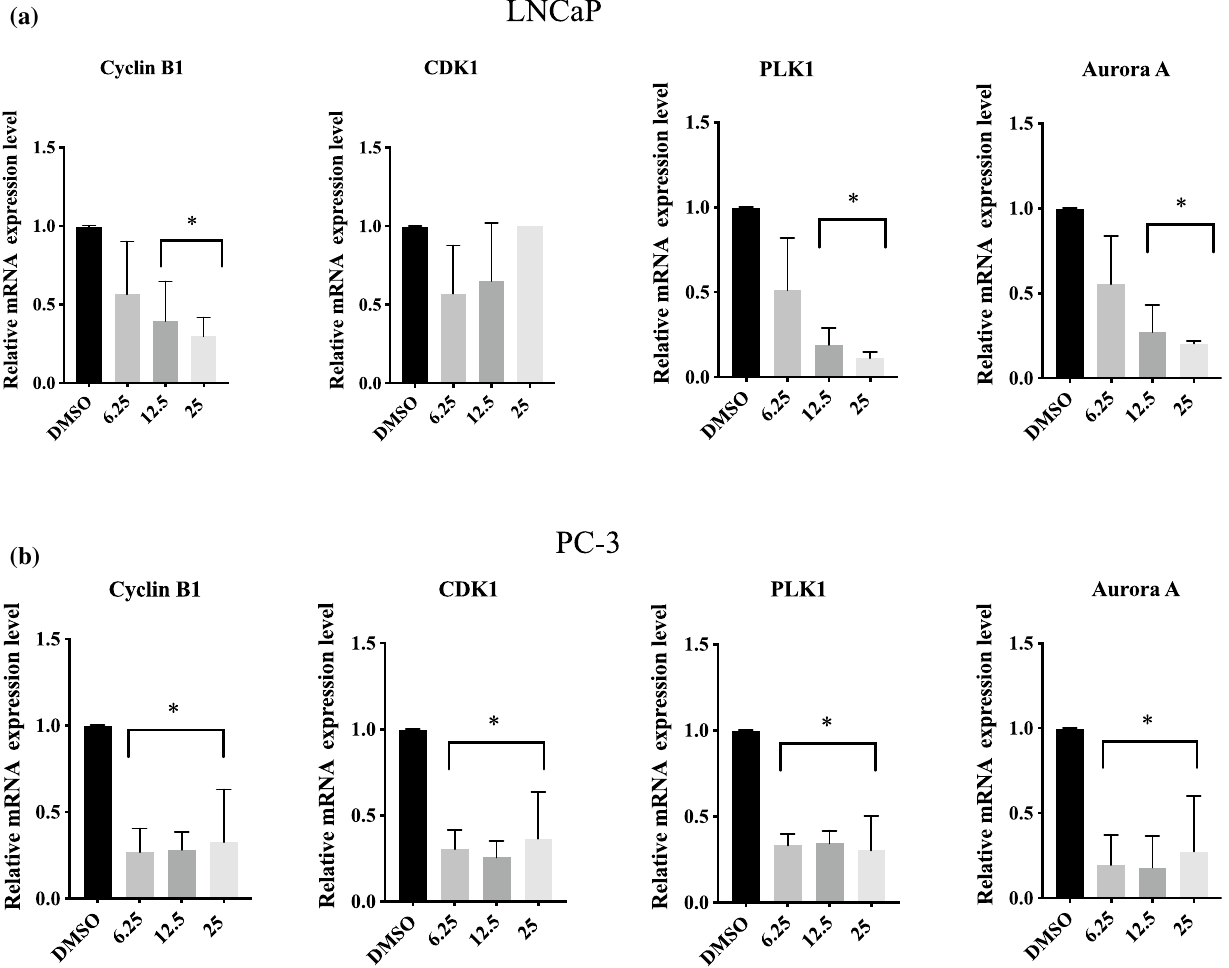
Fig. 5 Apigenin reduced mRNA level of the regulators that govern G to M transition in prostate cancer cells. a LNCaP and b PC-3 cells were 2 treated with a dose range of apigenin (0–25 µM) for 72 h and harvested for RT-PCR. The relative mRNA expression levels from were calcu- lated using REST 2009 software The data from were shown as the mean ± SD from three different experiments. *p < 0.05 compared to control